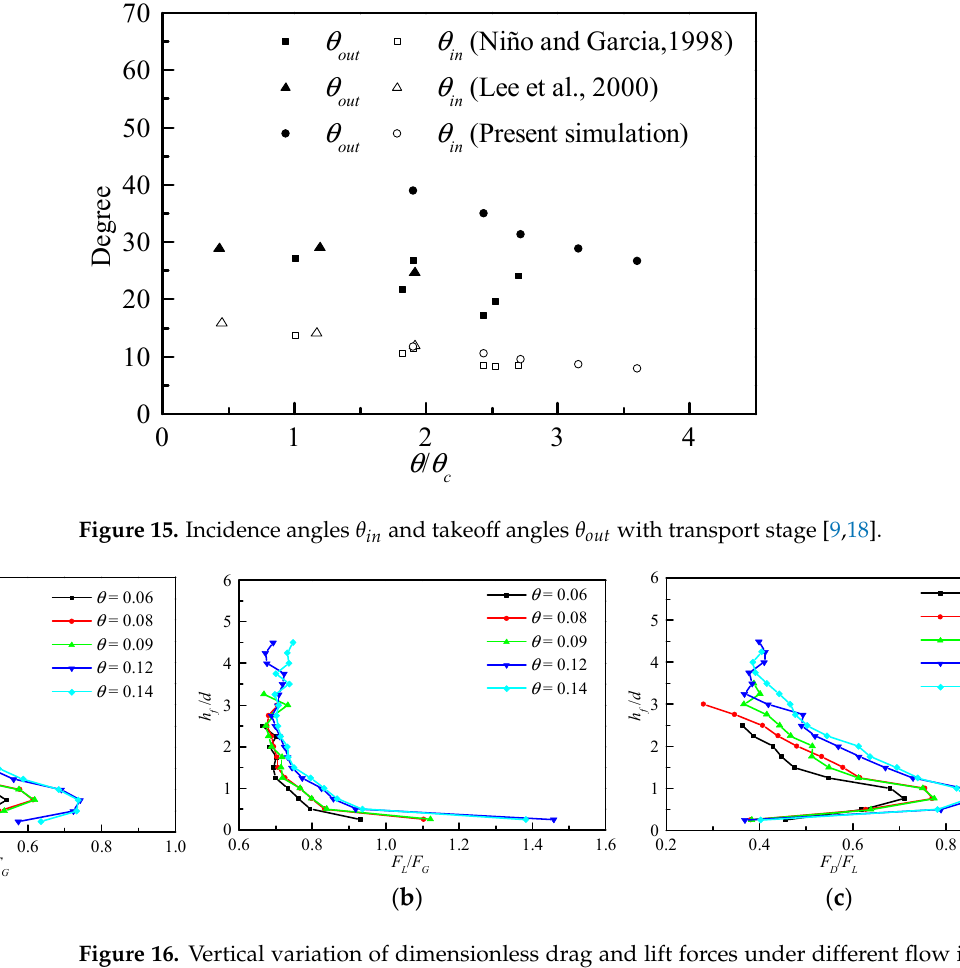
Figure 16. Vertical variation of dimensionless drag and lift forces under different flow intensities. ( a ) Drag force. ( b ) Lift force. ( c ) Relative magnitude of the drag and lift forces.